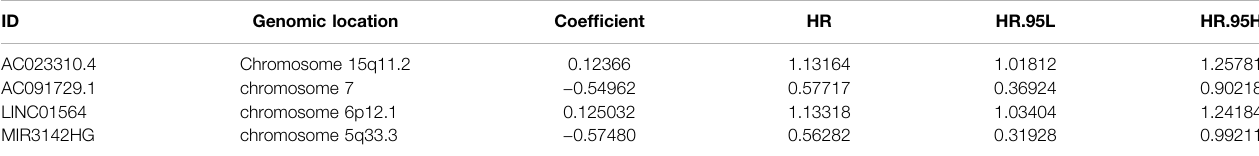
TABLE 2 | Overall information of four genomic instability-associated lncRNAs signi fi cantly associated with the prognosis of patients with head and neck squamous cell carcinoma. ID